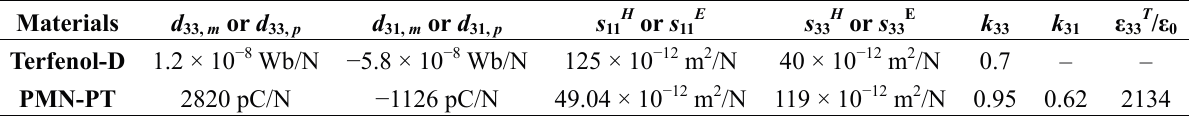
Table 1. Material parameters for Terfenol-D and PMN–PT single crystals.